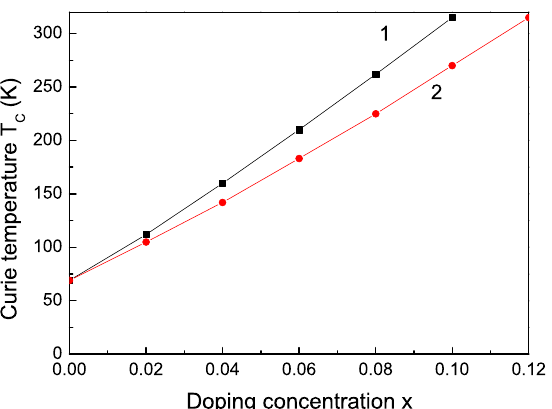
Figure 4. Ion-doping concentration dependence of the Curie temperature T C of a MgO NP, d = 20 nm, for Fe (1), Co (2).